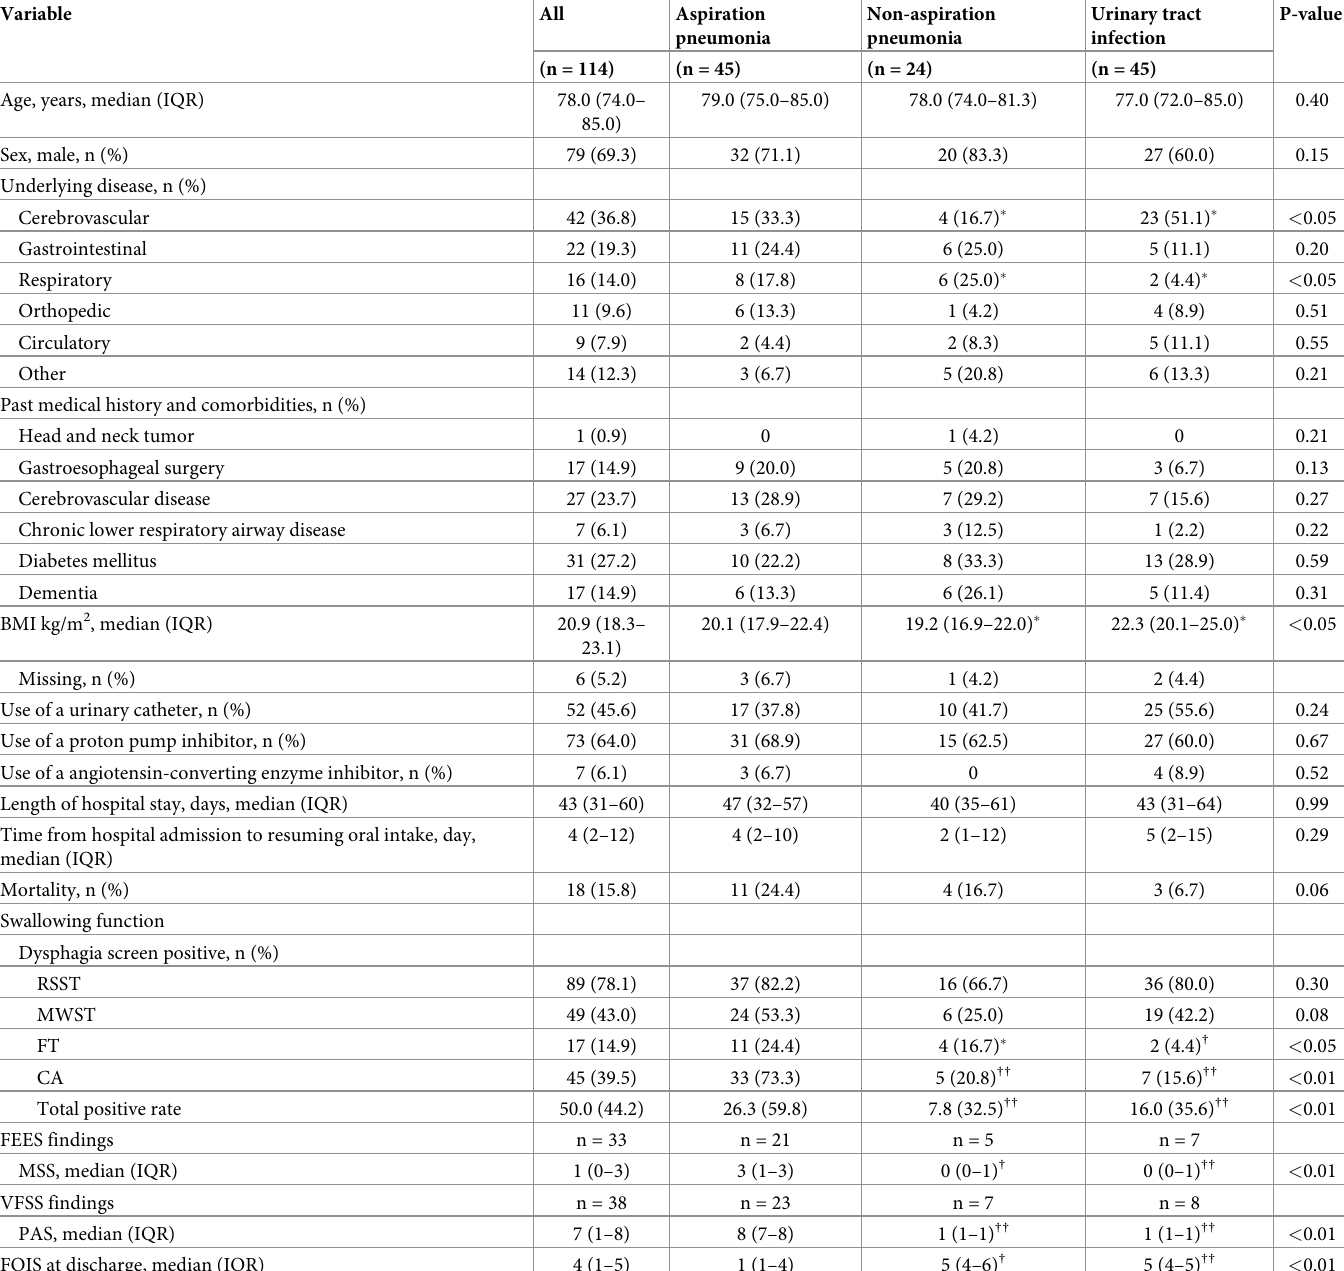
Table 1. Patient characteristics and swallowing